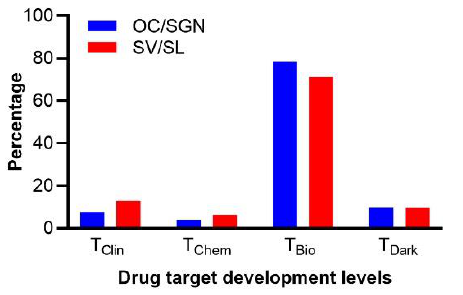
Figure 6. Transcriptomic analysis reveals the druggable landscape for the treatment of age-re- lated loss of cochlear function. The drug target development levels of the products encoded by the differentially expressed genes (DEGs) associated with ageing in the OC/SGN (blue) and SV/SL (red) were determined using the Pharos database. The relative percentages per substructure per level are plotted as a function of